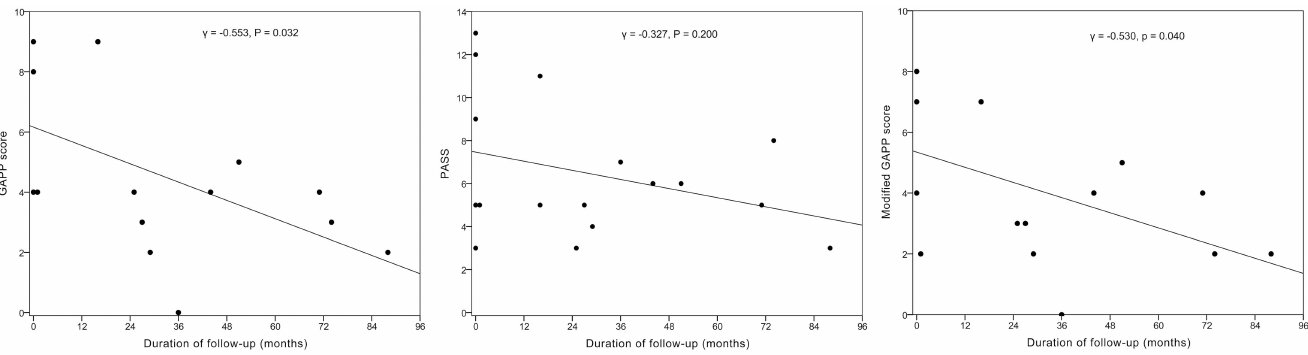
Fig 3. Correlation of the Grading systemfor Adrenal Pheochromocytoma and Paraganglioma (GAPP) score, Pheochromocytoma of the Adrenal Scaled Score (PASS), and modified GAPP (M-GAPP) score at baseline with the time (months) to metastasisafter the initial